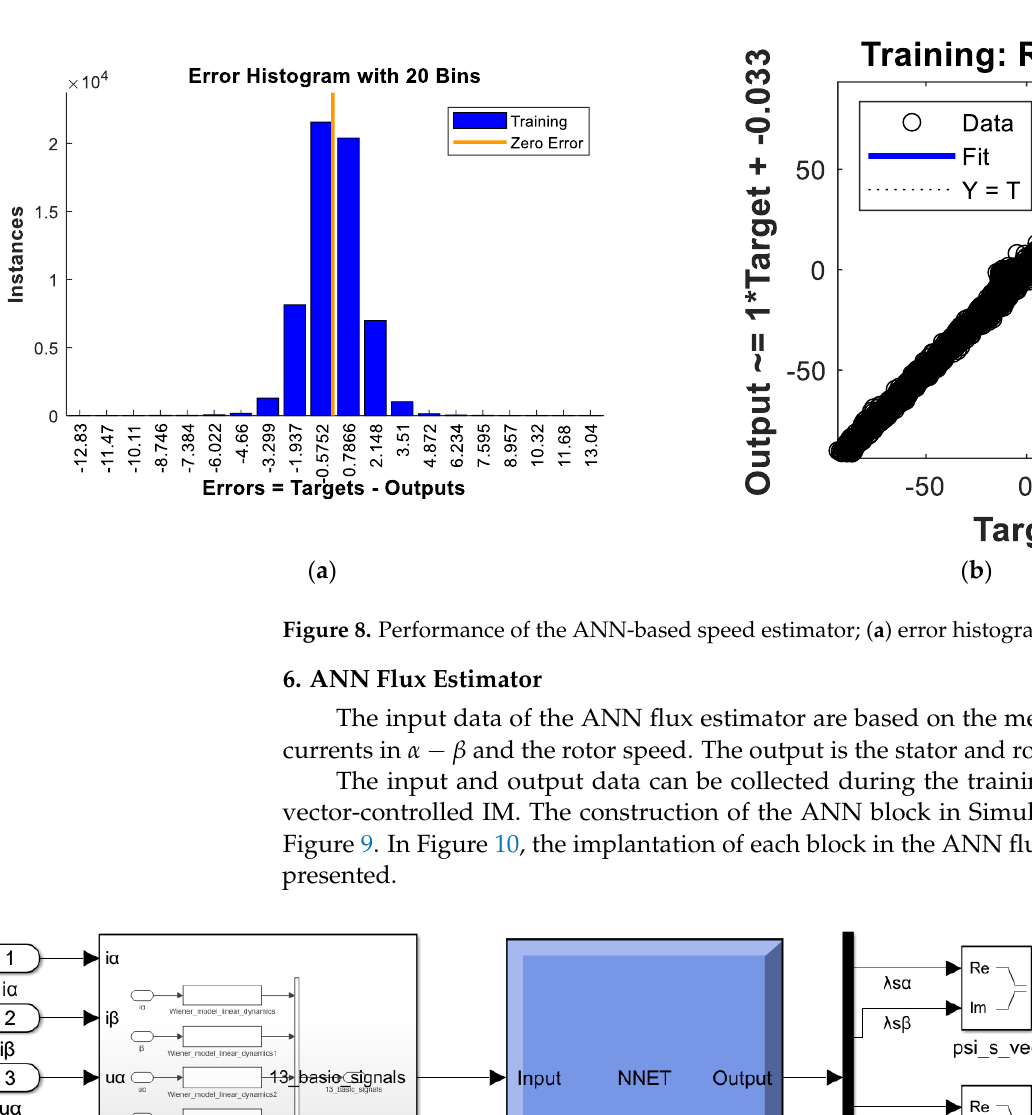
Figure 7. Performance of the ANN-based speed estimator considering mean squared error (MSE).